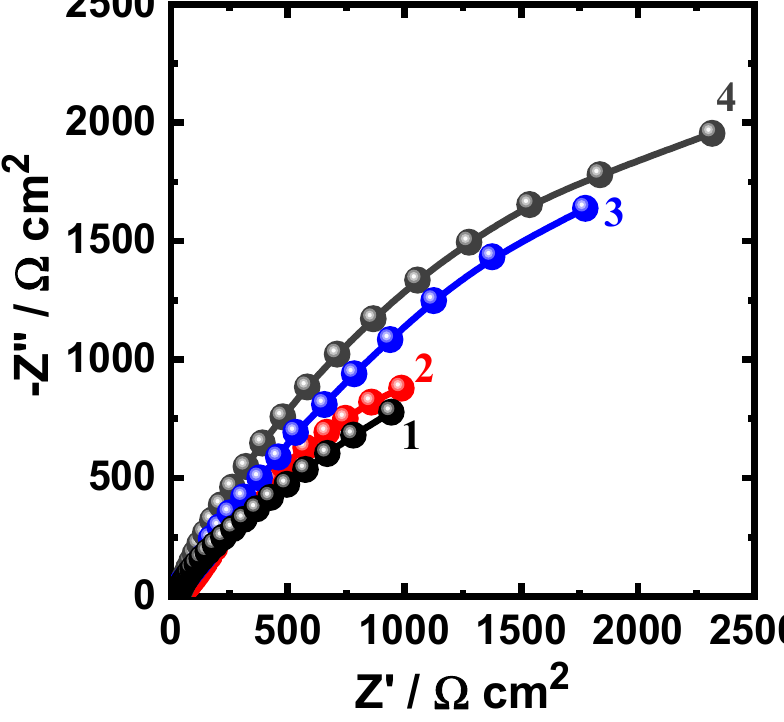
Figure 9. Nyquist spectra for iron after its exposure for 48 h to (1) 3.5% NaCl solutions in the absence and presence of (2) 5 × 10 − 5 M MAO, (3) 1 × 10 − 4 M MAO, and (4) 5 × 10 − 5 M MAO, respectively.